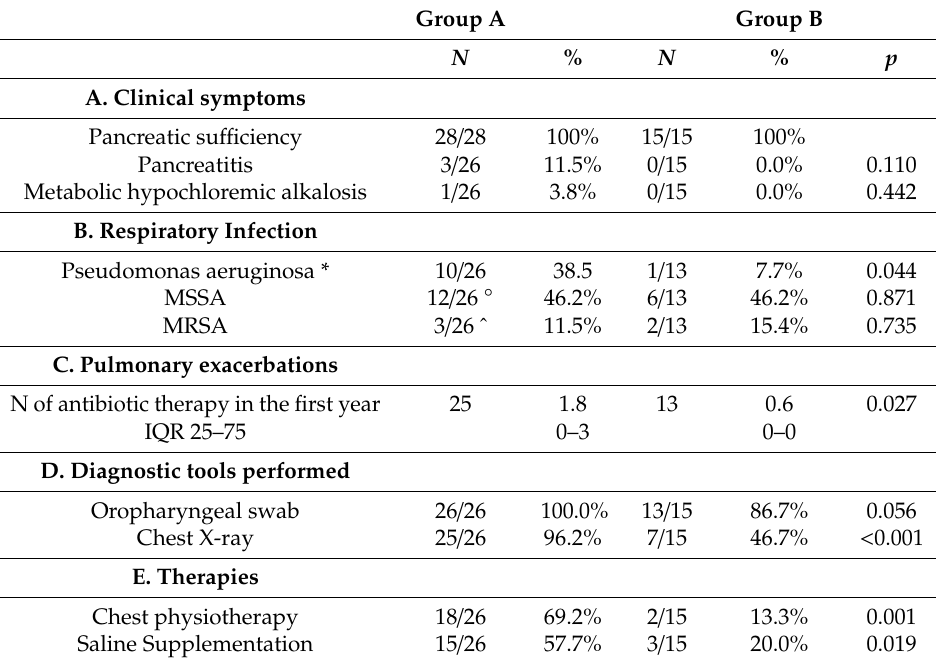
Table 2. Clinical characteristics of CRMS / CFSPID